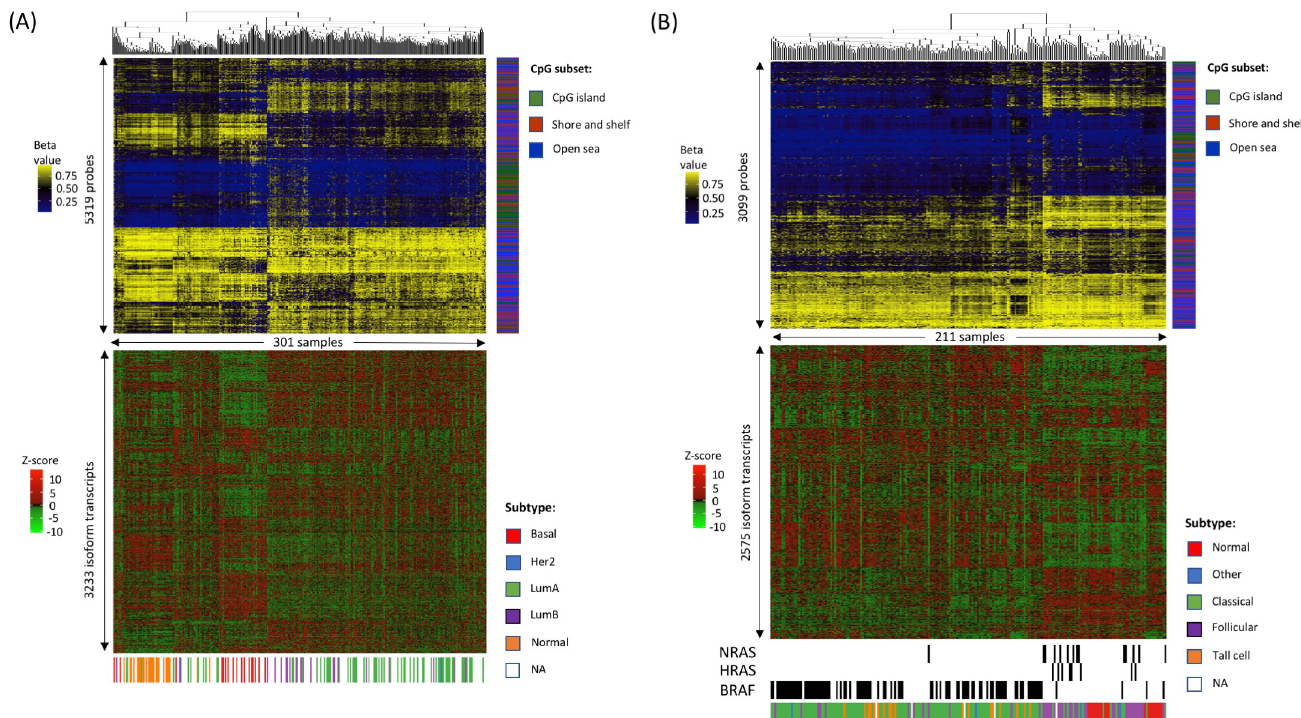
Fig 4. Clustering patterns of correlated DNA methylation and isoform usage patterns are consistent with predefined cancer subtypes. Two vertically aligned heat maps were generated using correlated DNAm patterns ( top ) and isoform usage patterns ( bottom ) for (A) breast cancer and (B) thyroid cancer. Columns in the methylation heat maps represent samples clustered based on DNAm levels of isoform-correlated probes. Columns in the isoform usage heat maps represent usage levels of DNAm-correlated isoforms of clustered samples. Abbreviations: Her2, Her2-positive; LumA, luminal A; LumB, luminal B. Location of DNAm probes as a subset of CpG positions (CGI, shores and shelves or open sea regions) are shown in side bar. Driver mutations are shown for thyroid cancer samples ( NRAS , HRAS , BRAF